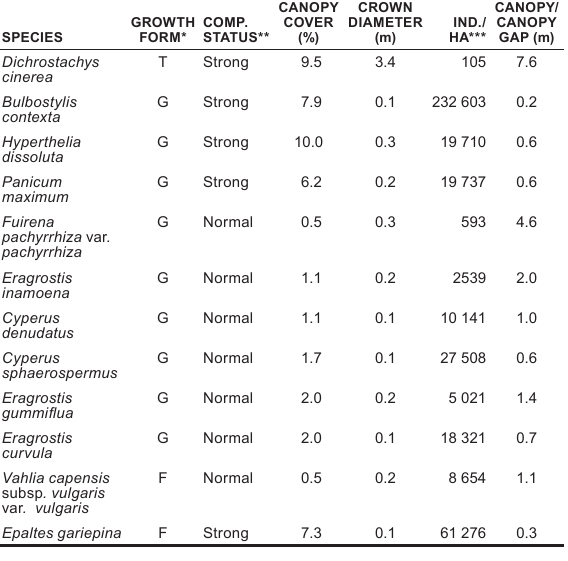
table 10 Species and growth form relations in Community 3